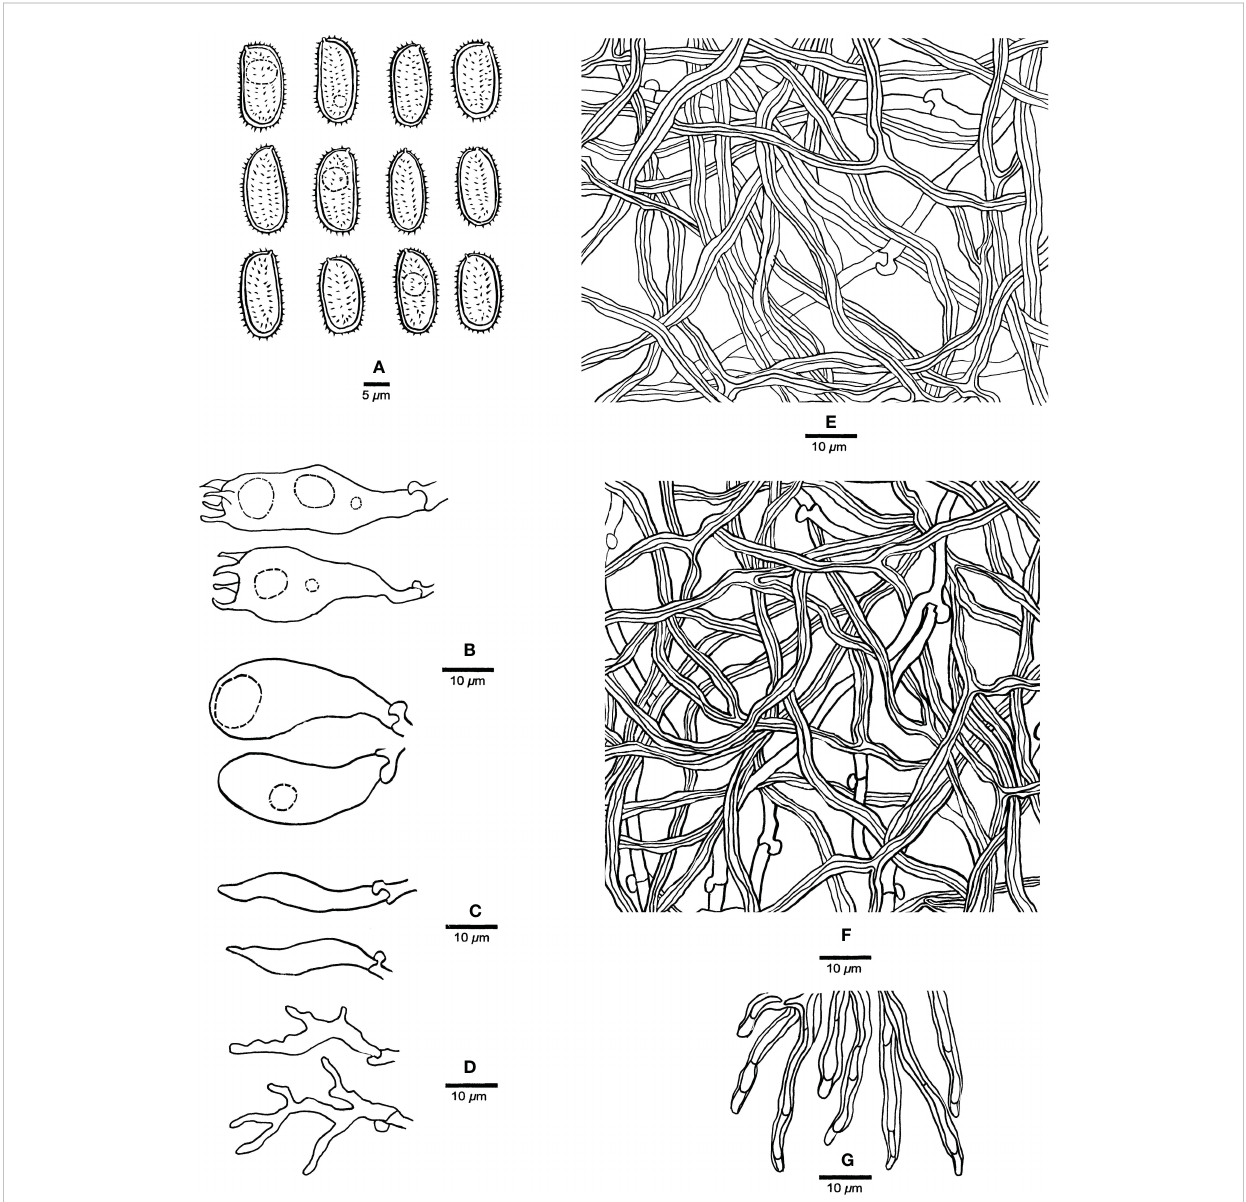
FIGURE 3 Microscopic characteristics of Haploporus ecuadorensis (Holotype, JV1906/C10-J). (A) Basidiospores. (B) Basidioles and basidia. (C) Cystidioles. (D) Dendrohyphidia. (E) Hyphae from subiculum. (F) Hyphae from tube trama. (G) Dissepiment hyphae. Scale bars: a = 5 m m, b – e = 10 m